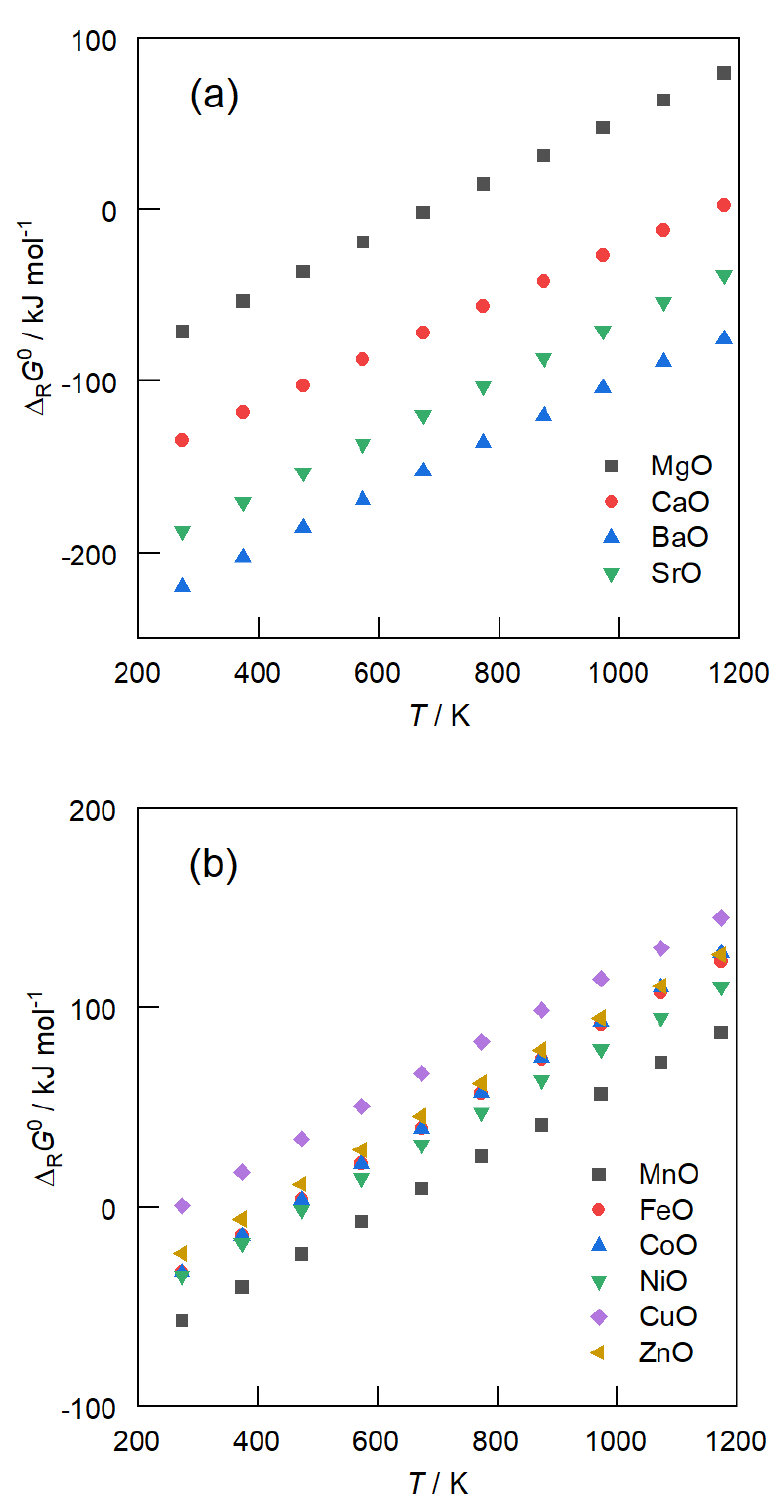
Figure 1. Standard free enthalpies of reaction Δ R G 0 for carbonate formation from metal oxides be- tween 300 and 1200 K at ambient pressure: calculated with HSC Chemistry 8; MeO + CO 2 ⇌ MeCO 3 ; ( a ) alkaline-earth-metal oxides and ( b ) transition-metal oxides.